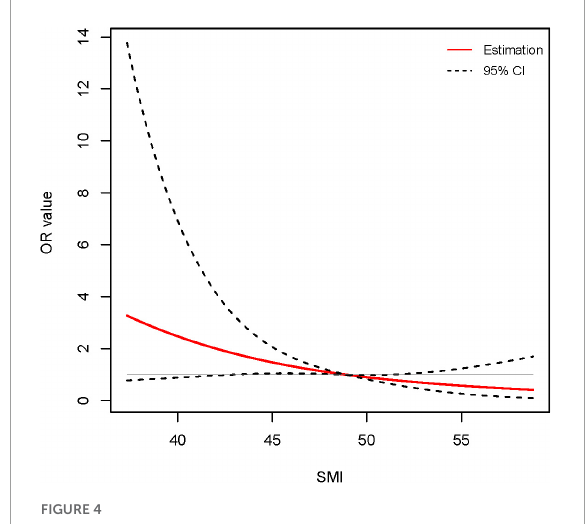
FIGURE4 Association between skeletal muscle mass index (SMI) level and long-term (1-year) incidence of cirrhosis in young (age ≤ 40 years) male acute-on-chronic liver failure (ACLF) patients using restricted cubic spline (RCS) analysis ( P for non-linear = 0.905). Results were corrected with international normalized ratio